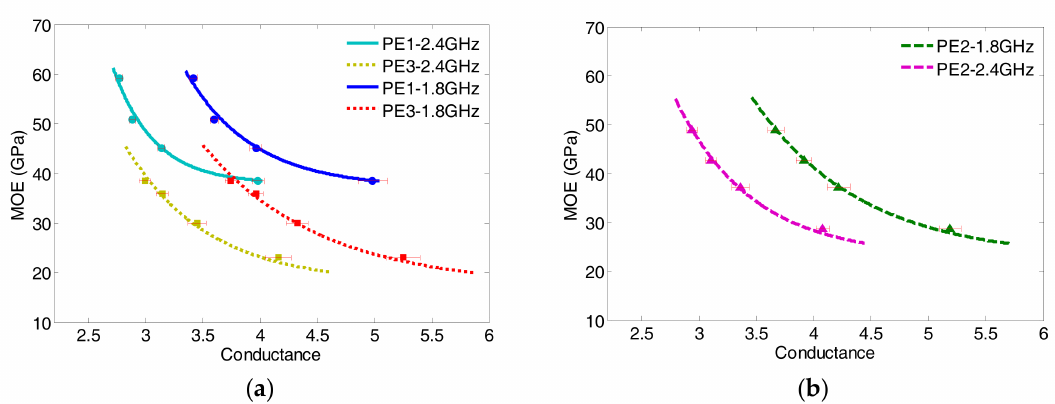
Figure 11. MOE-Conductance correlation using dual frequency for ( a ) comparison of PE1 and PE3 specimens; ( b ) only PE2 specimen.